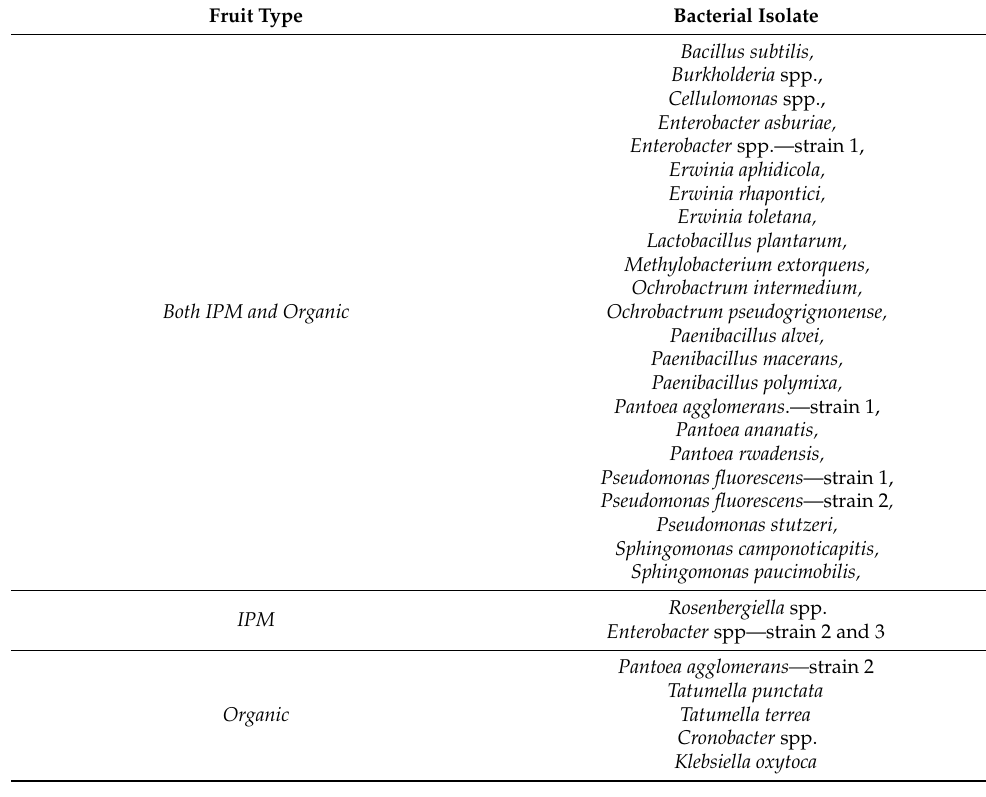
Figure 2. ( a ) Principal component analysis of bacterial families of raspberry fruits ‘Enrosadira’ cultivated with organic or IPM practices. Ellipses enclose confidence level = 95%. ( b ) Correlation circle plot with discriminating bacterial families is shown. Table 1. Bacterial genera and species isolated from raspberry fruits ‘Enrosadira’ cultivated with organic or IPM